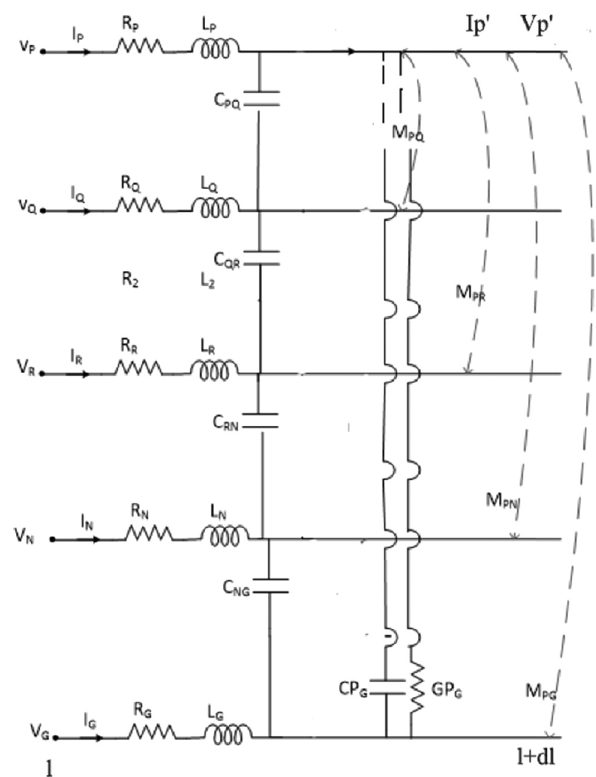
Figure 2: Process fl ow chart for transient analysis using DWT for an underground cable.